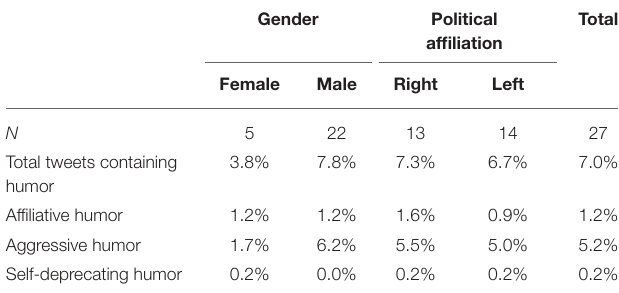
TABLE 3 | Percentage of tweets that contain humor depending on gender, and political